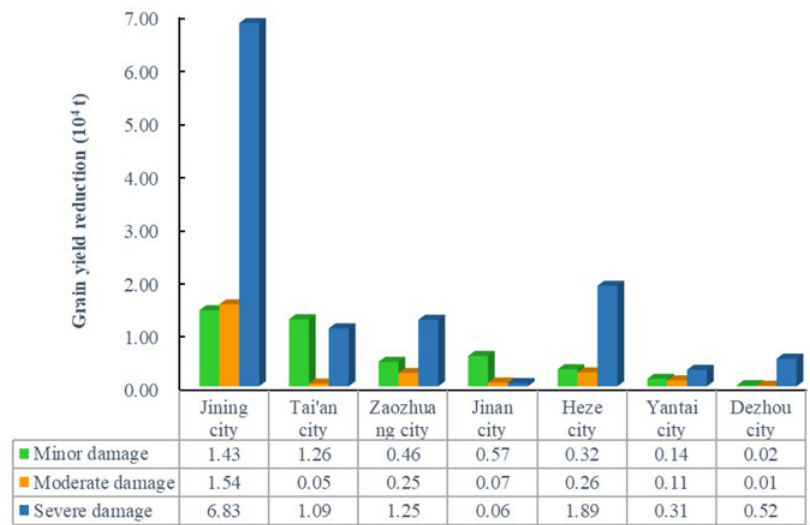
Figure 9. Grain yield reduction by 2030.